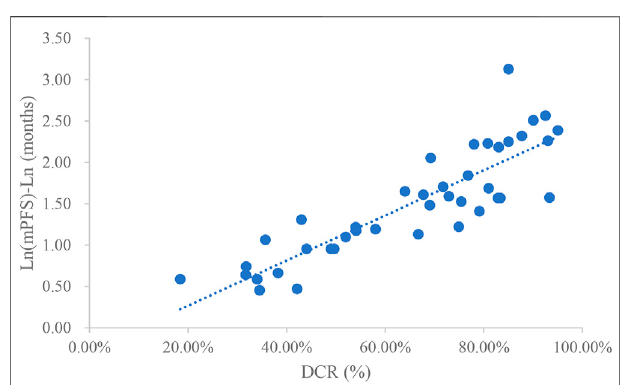
FIGURE 10 | Linear fi tting results for DCR and ln (mPFS).